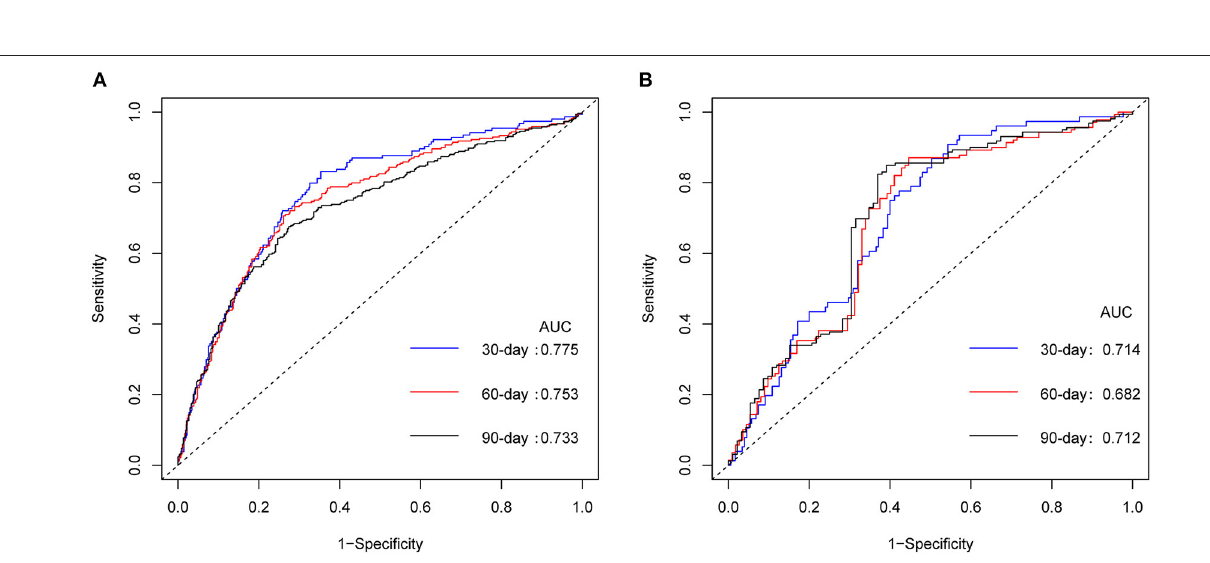
both the derivation and temporal validation cohorts ( Table 3 ). Using DCA, our nomogram provided superior net benefit and displayed improved performance in prognostic evaluation over the 30-, 60-, and 90-day periods, both in